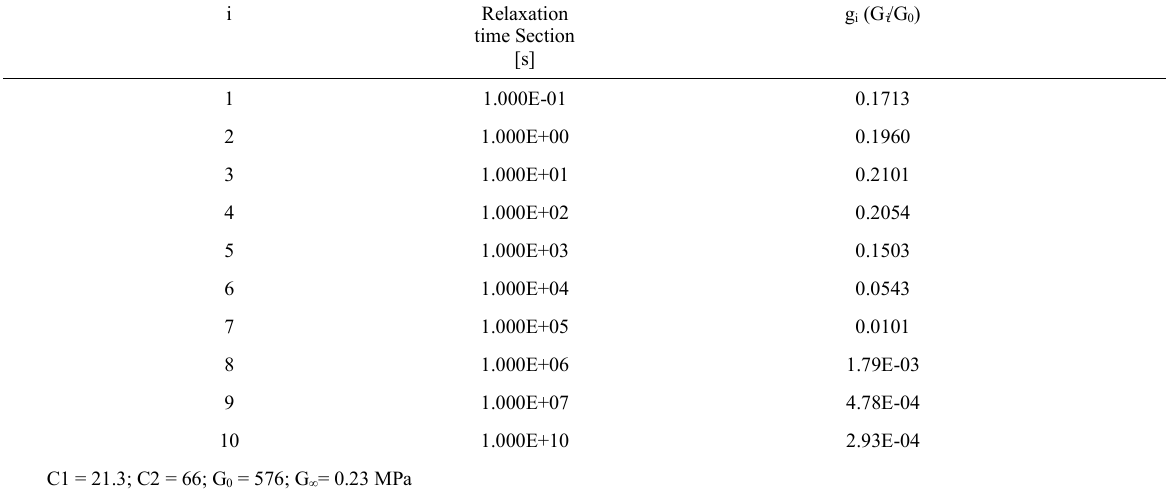
Table 3: Model parameters for the evaluation shear relaxation modulus G(t,T) for Saflex Structural DG interlayer (T ref = 20